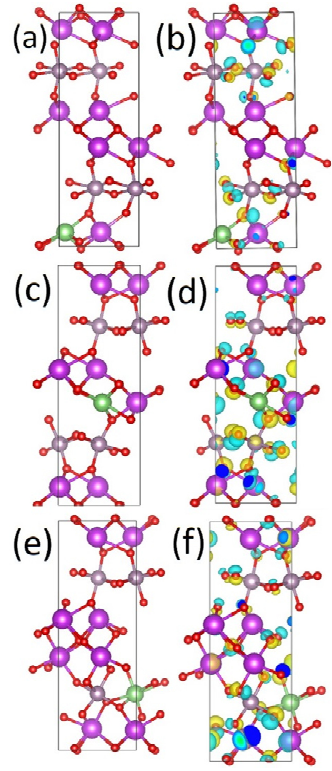
Figure 8. Side view of the optimised Li substitutional defects for ( a ) Li Bi site one, with charge density di ff erence plot in ( b ), ( c ) Li Bi site two, with its corresponding charge density plot in ( d ), and ( e ) Li Mo and its charge density di ff erence plotted in ( f ). Purple spheres are Bi, grey Mo, green Li, and red O. Yellow iso-surface represents an increase in charge density upon lithium substitution, whereas blue represents depletion of charge